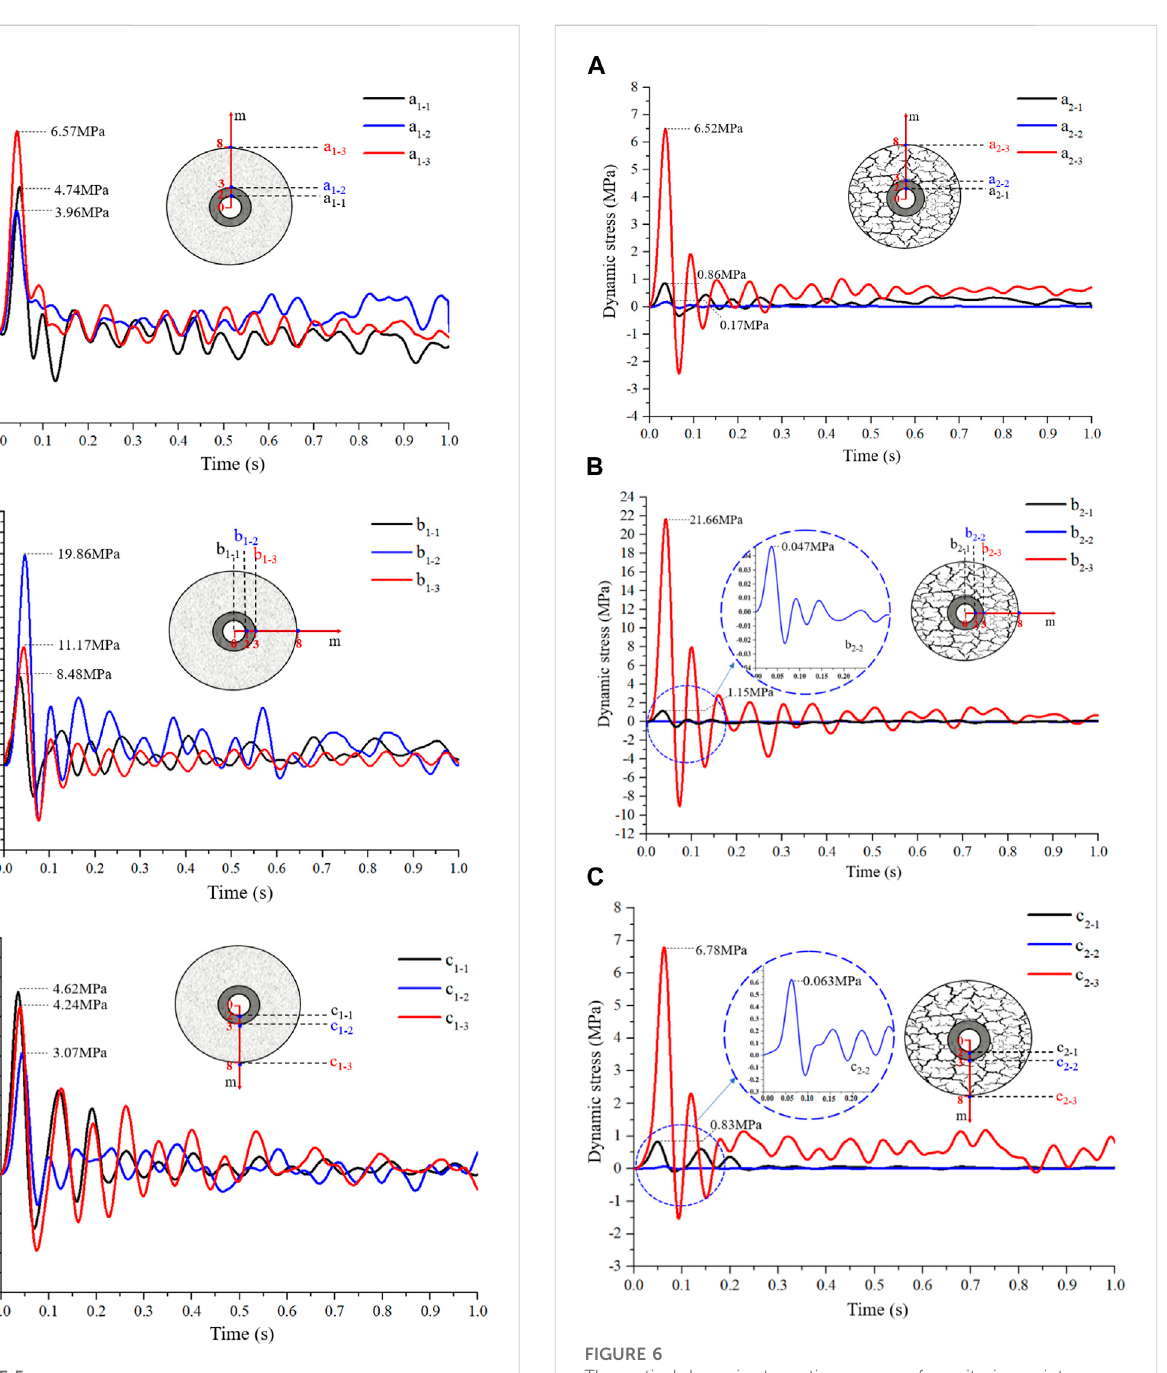
FIGURE 5 The vertical dynamic stress-time curves of monitoring points located at (A) roadway top, (B) roadway side, and (C) roadway bottom in the unmodi fi ed roadway.